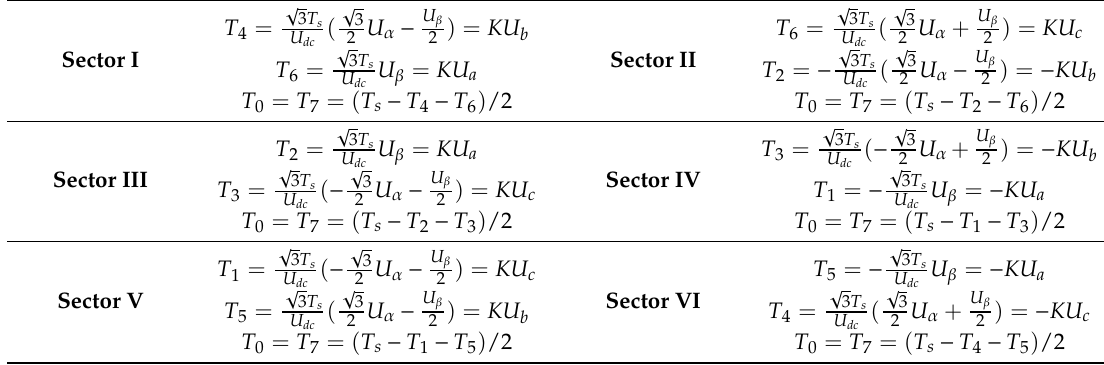
Table 2. The time of the basic space vector of each sector.